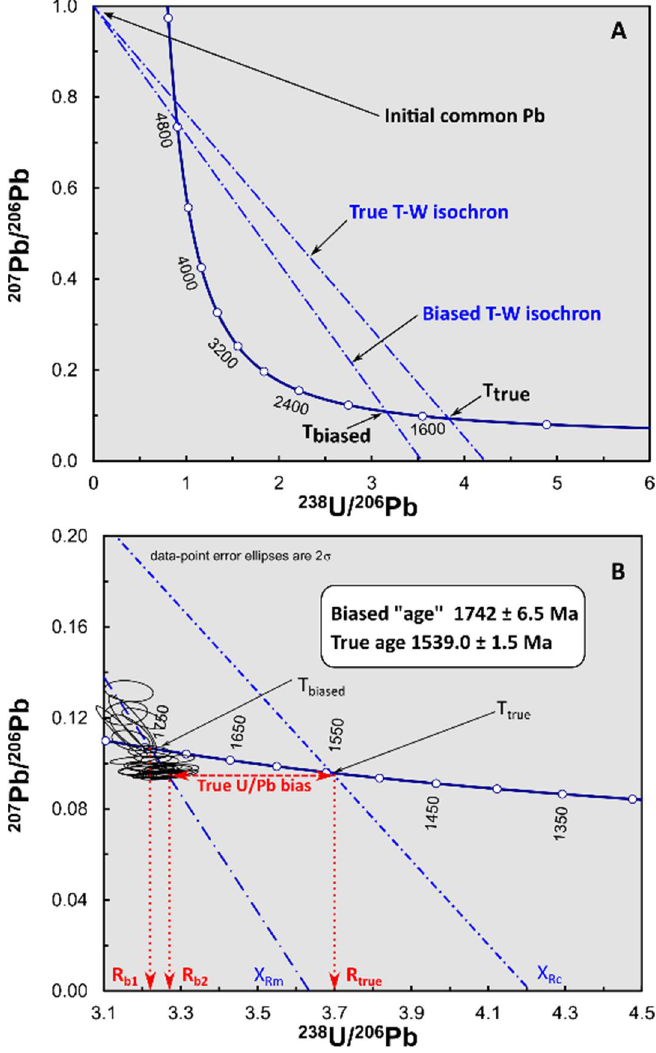
Figure 9. Procedure to determine the correction factor “F” of sample 238 U/ 206 Pb using the measured array of SPG cassiterite as a reference and assuming no matrix effect for Pb-isotope ratios ( A ). The difference between the true U/Pb bias and the bias calculated from the ratio of ages is shown in ( B ). This figure also shows data (open ellipses) for the SPG reference cassiterite measured in an analytical session.